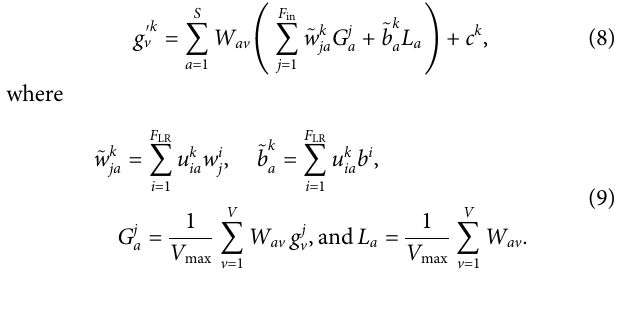
Frontiers in Big Data |